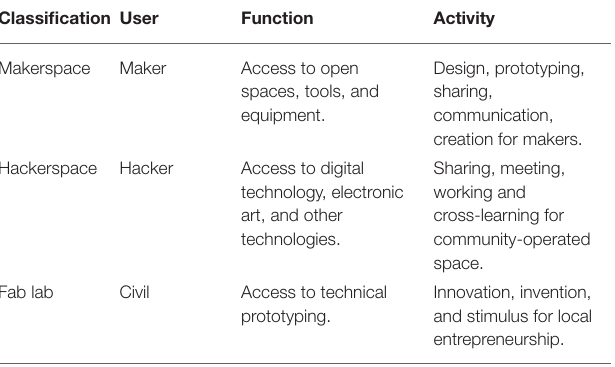
TABLE 1 | Three classifications of incubated platforms